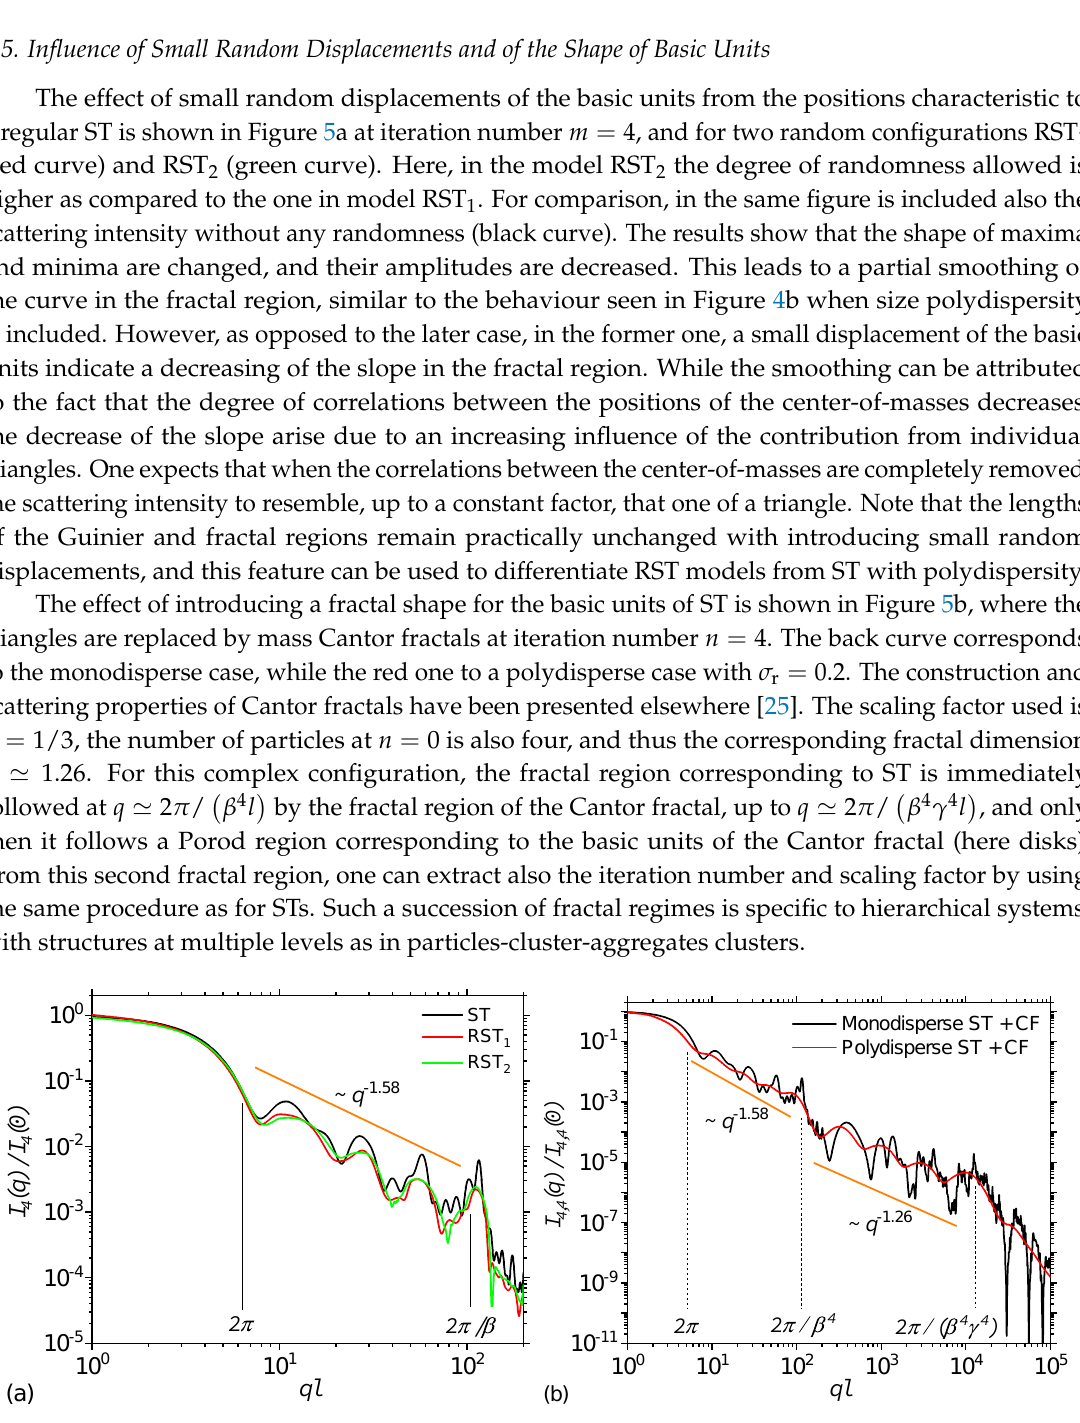
Figure 5. ( a ) Form factor of ST, and two randomized versions of ST (RST 1 and RST 2 ) as shown in Figure 2c at iteration m = 4. In the model RST 2 the positions of triangles is allowed a higher degree of freedom as compared to model RST 1 . ( b ) Form factor of a complex fractal consisting from disks forming a Cantor fractal at iteration n = 4, which in turn is arranged as the triangles in a ST fractal, also at iteration m = 4 (see Figure